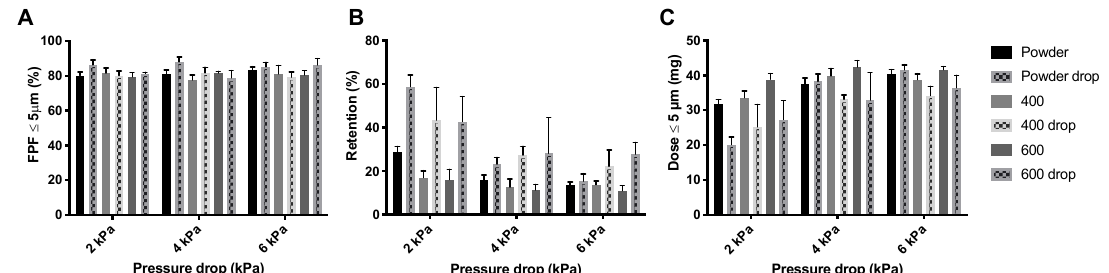
Figure 10. The effect of the drop test on the inhaler dispersion of 55 mg isoniazid. Panel ( A ) shows the FPFs for the powder, and the 400 and 600 mbar pellets before and after the drop test. Panel ( B ) shows the retention for these samples and panel ( C ) shows the FPD (average ± SD, n = 5). The FPD is calculated by multiplying the FPF with the emitted dose (=FPF × (1 − retention)). Similar to isoniazid, the FPF generated from the different amikacin products is not affected by